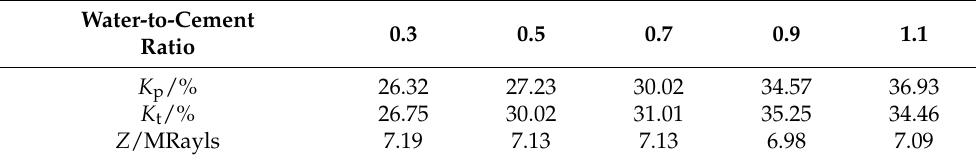
Table 1. Electromechanical and acoustic properties of the PZT–PC composites with different wa- ter/cement